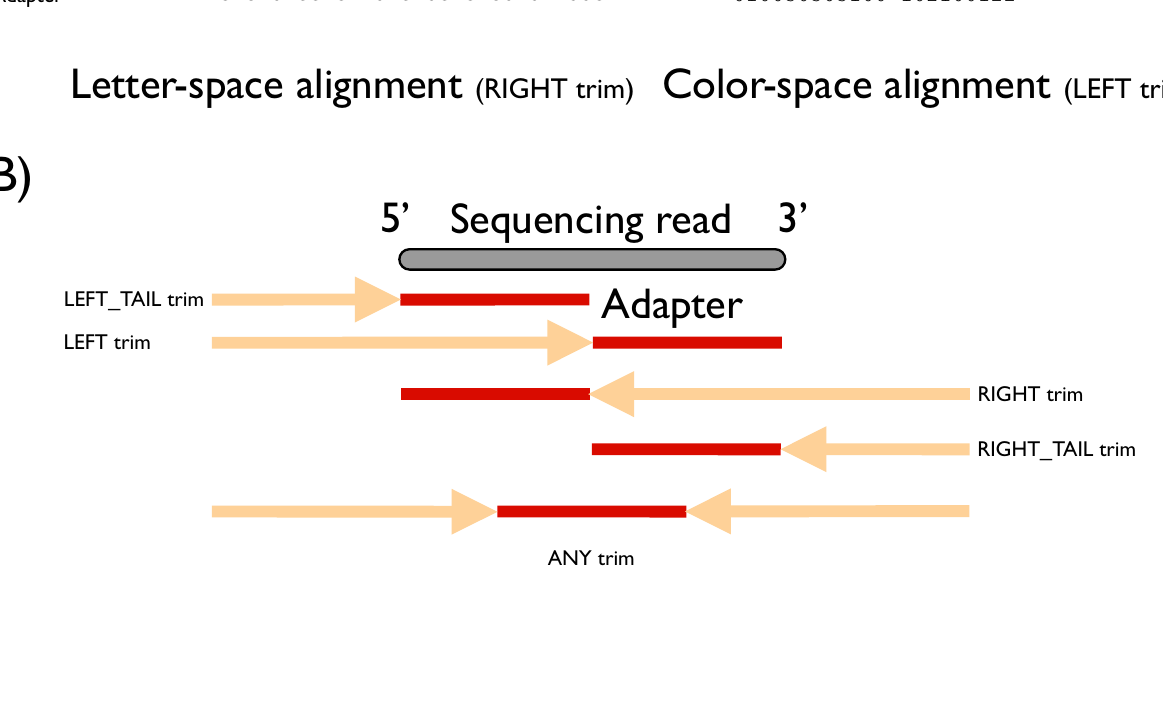
Letter-space alignment